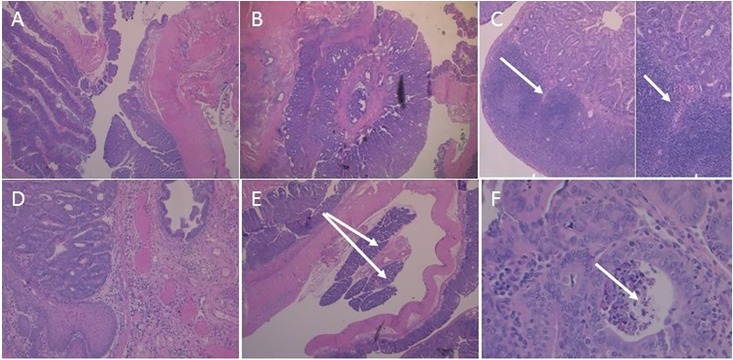
Representative histology of AOM/DSS-induced invasive adenocarcinoma.H&E stained sections from Swiss-rolled colons in wild type control (A; 25x magnification) and Hltf-deleted (B-F) tumors. B. A very large tumor nearly encircles the anal canal (25x magnification). C. Crohn’s disease-like reaction consisting of discrete lymphoid aggregates with germinal centers and invasion at arrow at 25x magnification and 100x magnification (inset). D. Anal canal with invasive tumor (100x magnification). E. Heterotopic (or ectopic) pancreas at arrows (25x magnification). F. Tumor necrosis (arrow) in the anal canal (100x magnification).